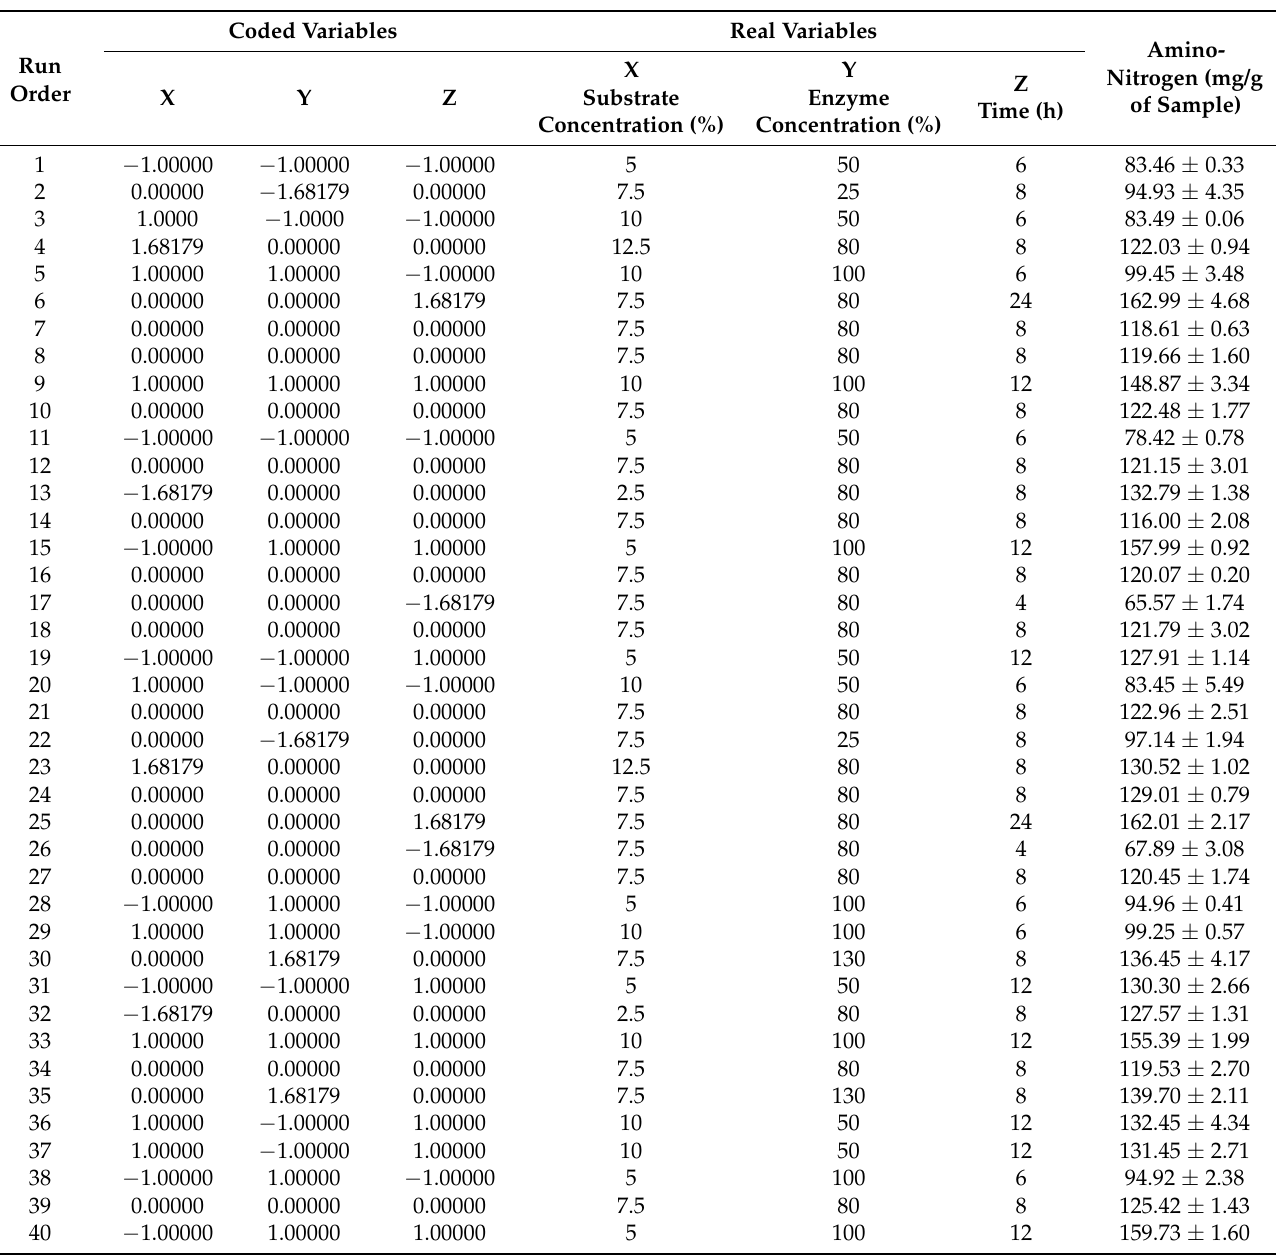
Table 4. Experimental design for chitin